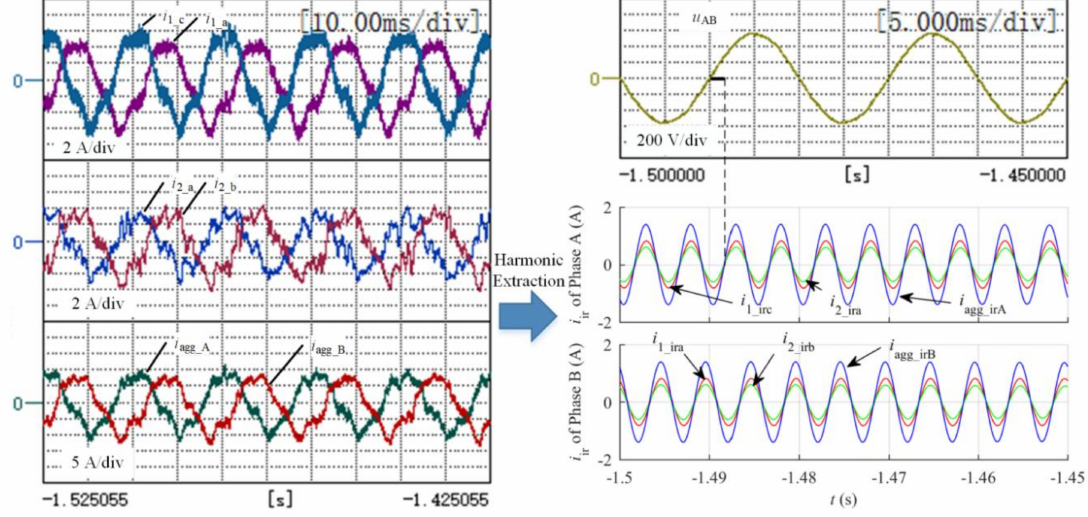
Figure 18. Actual positive sequence 200 Hz current.